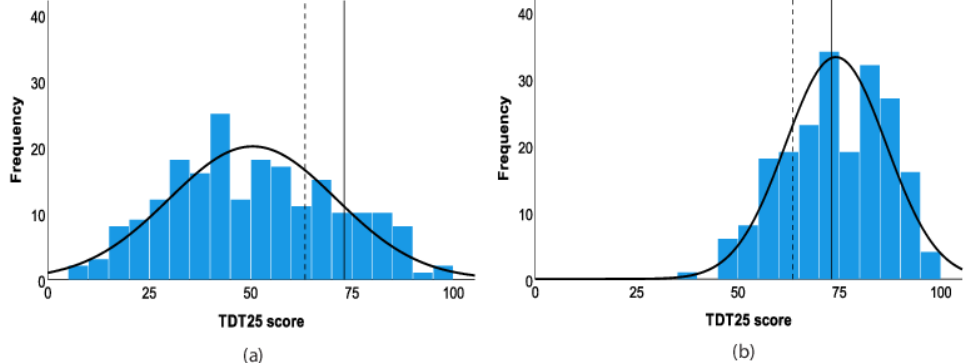
Figure 4. Frequency distributions of tactile discrimination for ( a ) contralesional and ( b ) ipsilesional hands of stroke participants. The solid horizontal lines represent the best estimate for the fifth percentile criterion of abnormality for the TDT25 test version (this criterion was defined from a sample of 100 healthy controls). The dashed lines represent the more conservative criterion of abnormality (zeroth percentile) in which all healthy TDT scores were